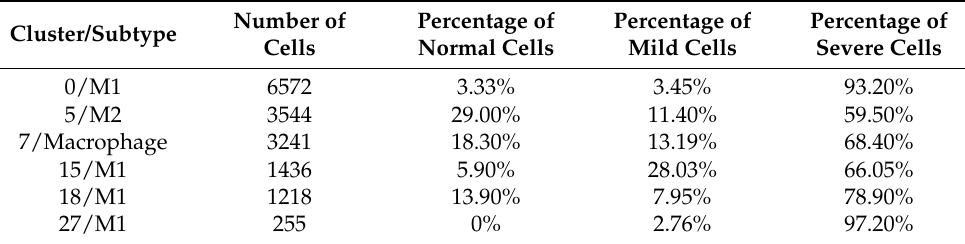
Table 6. Percentage of cells from normal, mild, and severe groups in the clusters assigned as macrophage